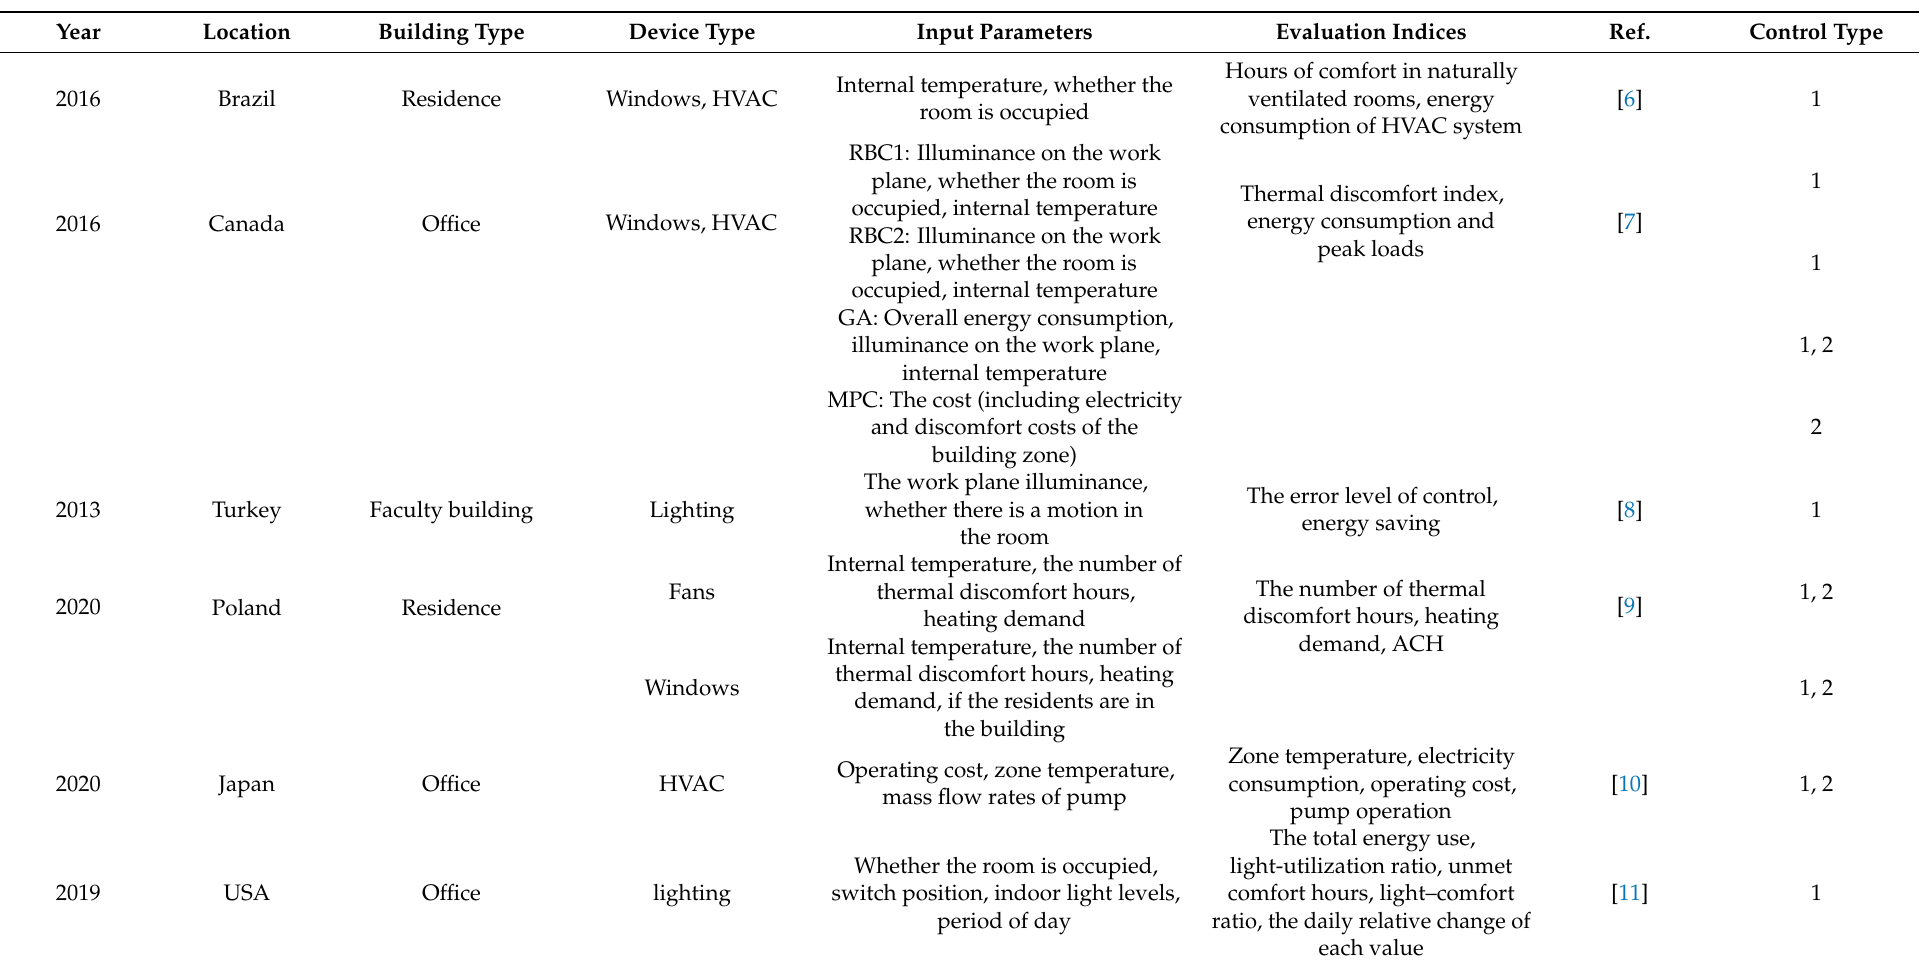
Table 1. Summary of existing operation